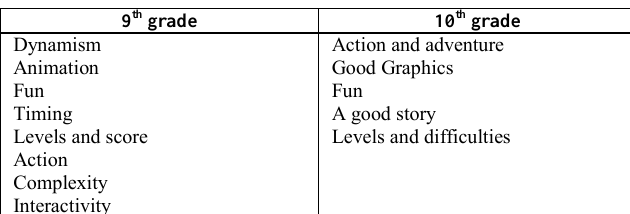
Table 4. Most valued aspects of general video games